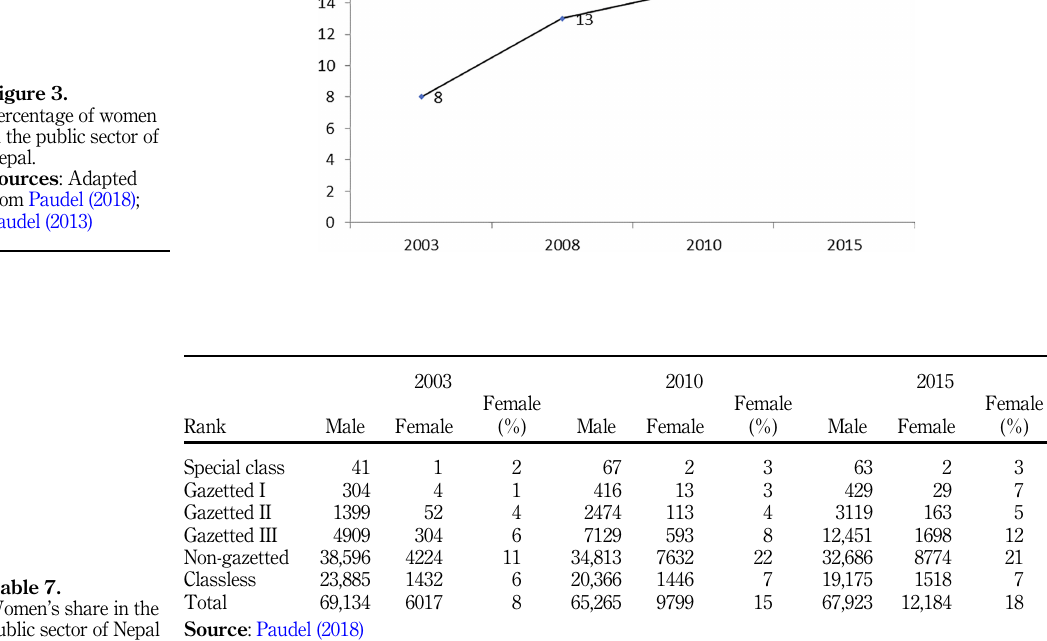
Figure 3. Percentage of women in the public sector of Nepal.